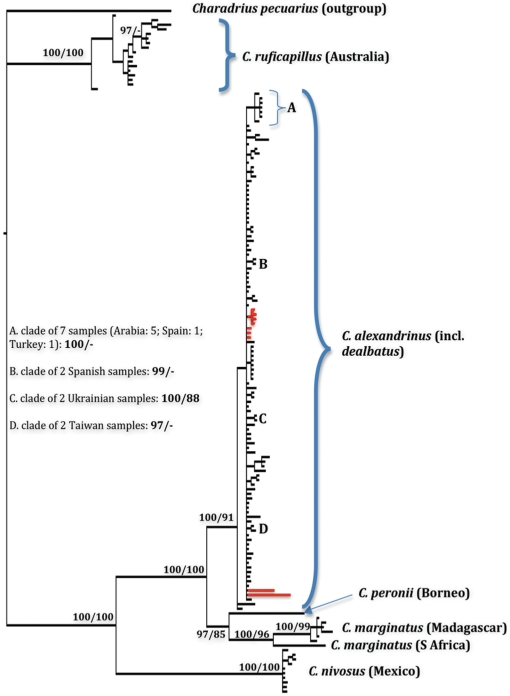
Phylogram of the concatenated dataset including all three mtDNA genes; nodal support is given in terms of Bayesian posterior probabilities (pp; multiplied by 100 for ease of interpretation) followed by maximum parsimony bootstrap (>75); only values of pp>96 are given; note that all major nodes are either highly supported (pp>96) or unsupported (pp<70), while values at 70≤pp≤96 only refer to less important population-internal nodes that are difficult to label; selected clades are letter-coded to indicate support values and sample identities; red background indicates dealbatus samples.